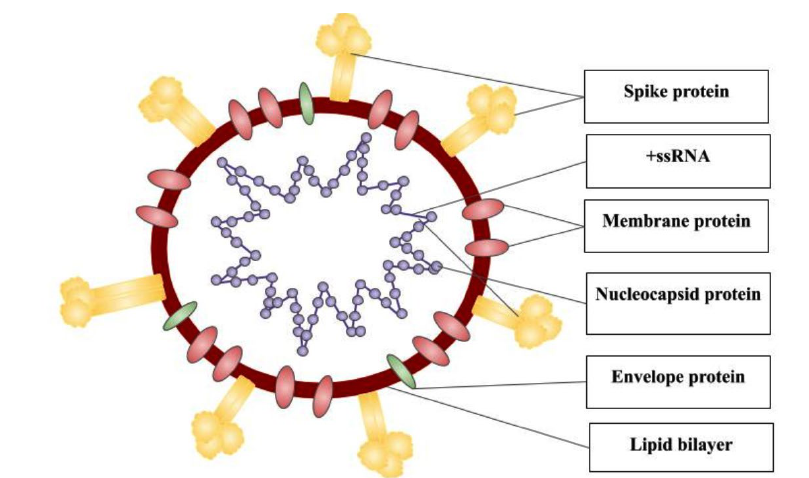
Fig. 3. SARS-CoV-2 Virion